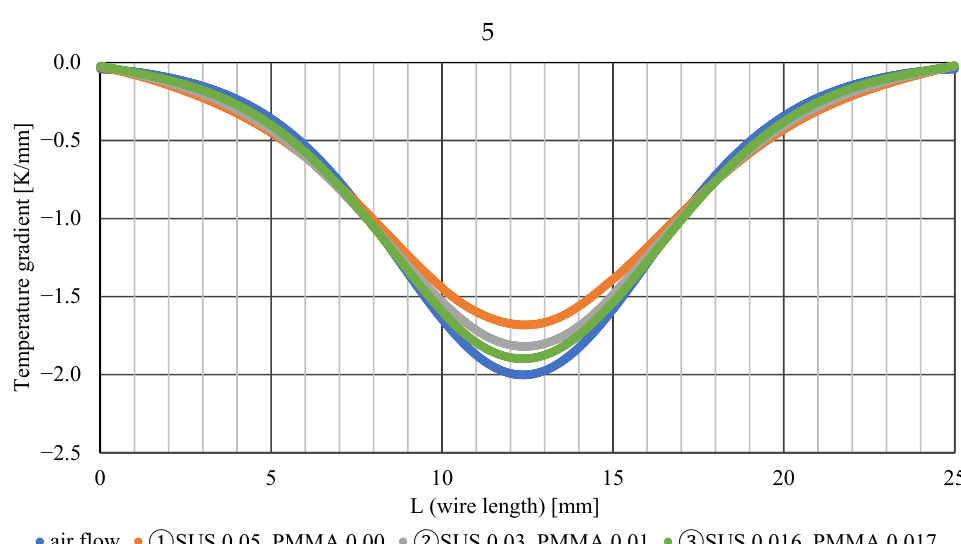
Figure 10. Temperature gradient.